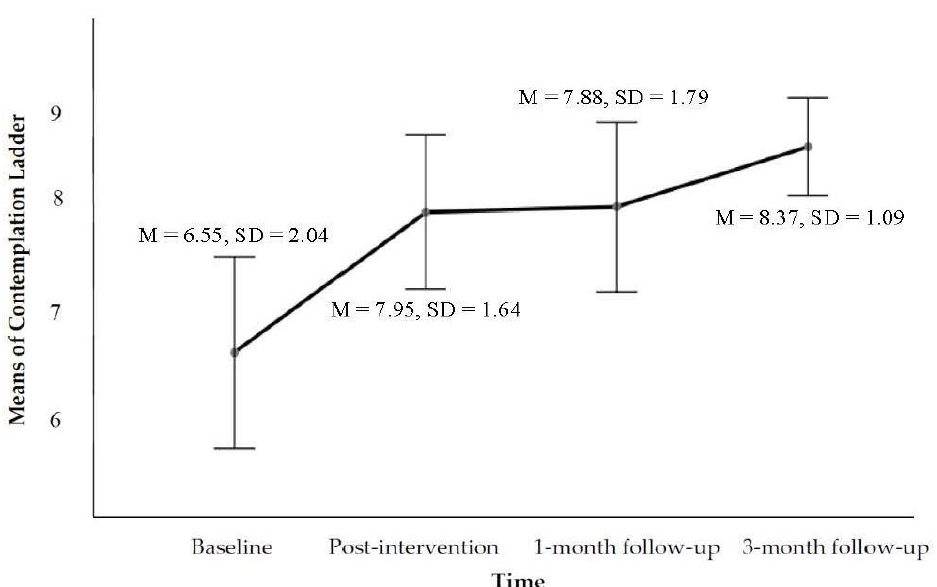
Figure 2. Estimated marginal means plot showing the change of contemplation ladder scores across the four time